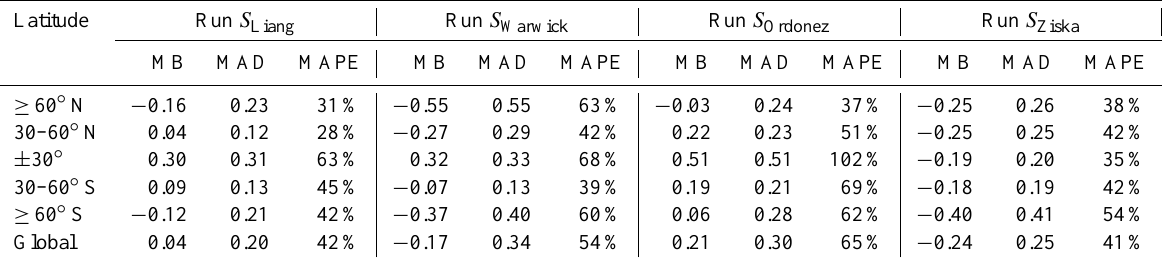
Table 5. Summary of calculated error metrics between CHBr 3 observed in the free troposphere during the HIPPO project (2009–2011) with analogous fields from CTM runs S Liang , S Warwick , S Ordonez and S Ziska . Shown are the MB and the MAD both in units of ppt. Also shown is the MAPE (see text). These fields were calculated for all observations made during HIPPO missions 1–5 for the 5 latitudinal bands shown in Fig. 4. A global value is also quoted for comparisons at all latitudes.